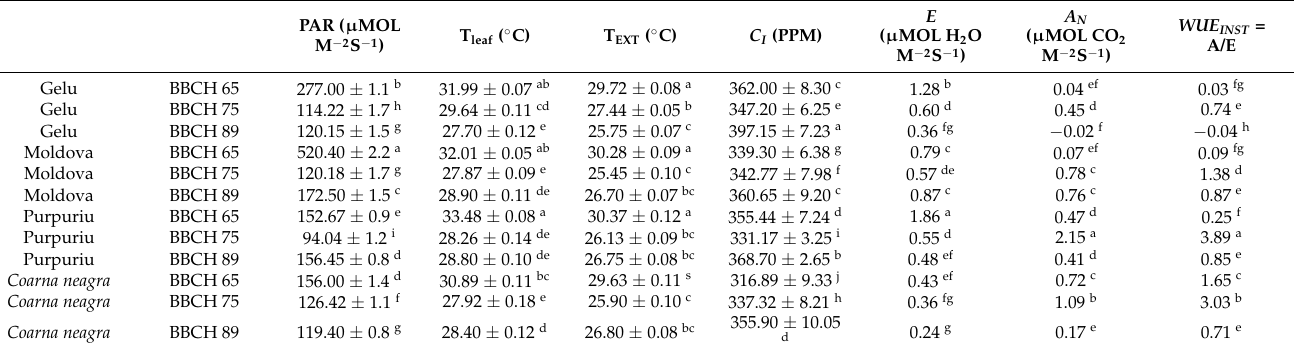
Table 4. The dynamic evolution of main photosynthetic parameters in the studied growth phases for the four analyzed varieties in the first